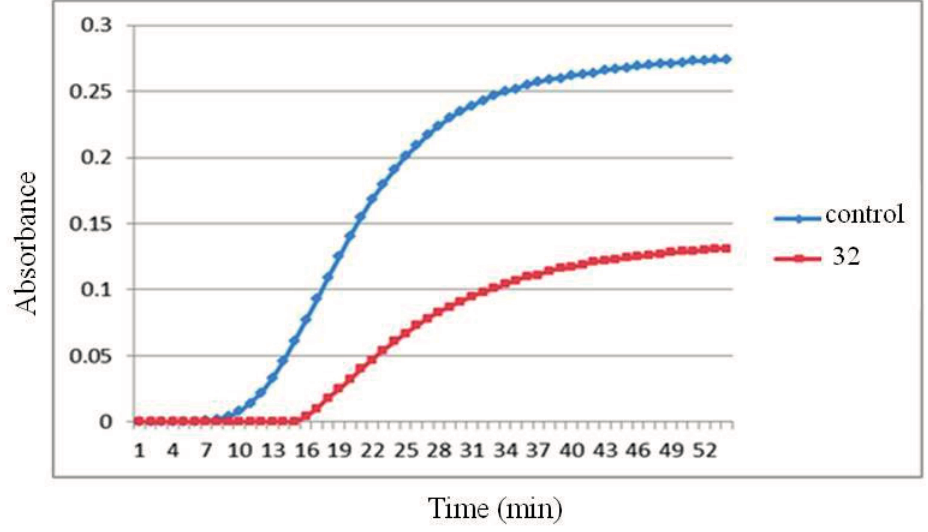
Figure 3. Tubulin polymerization inhibition of compound 32 at 40